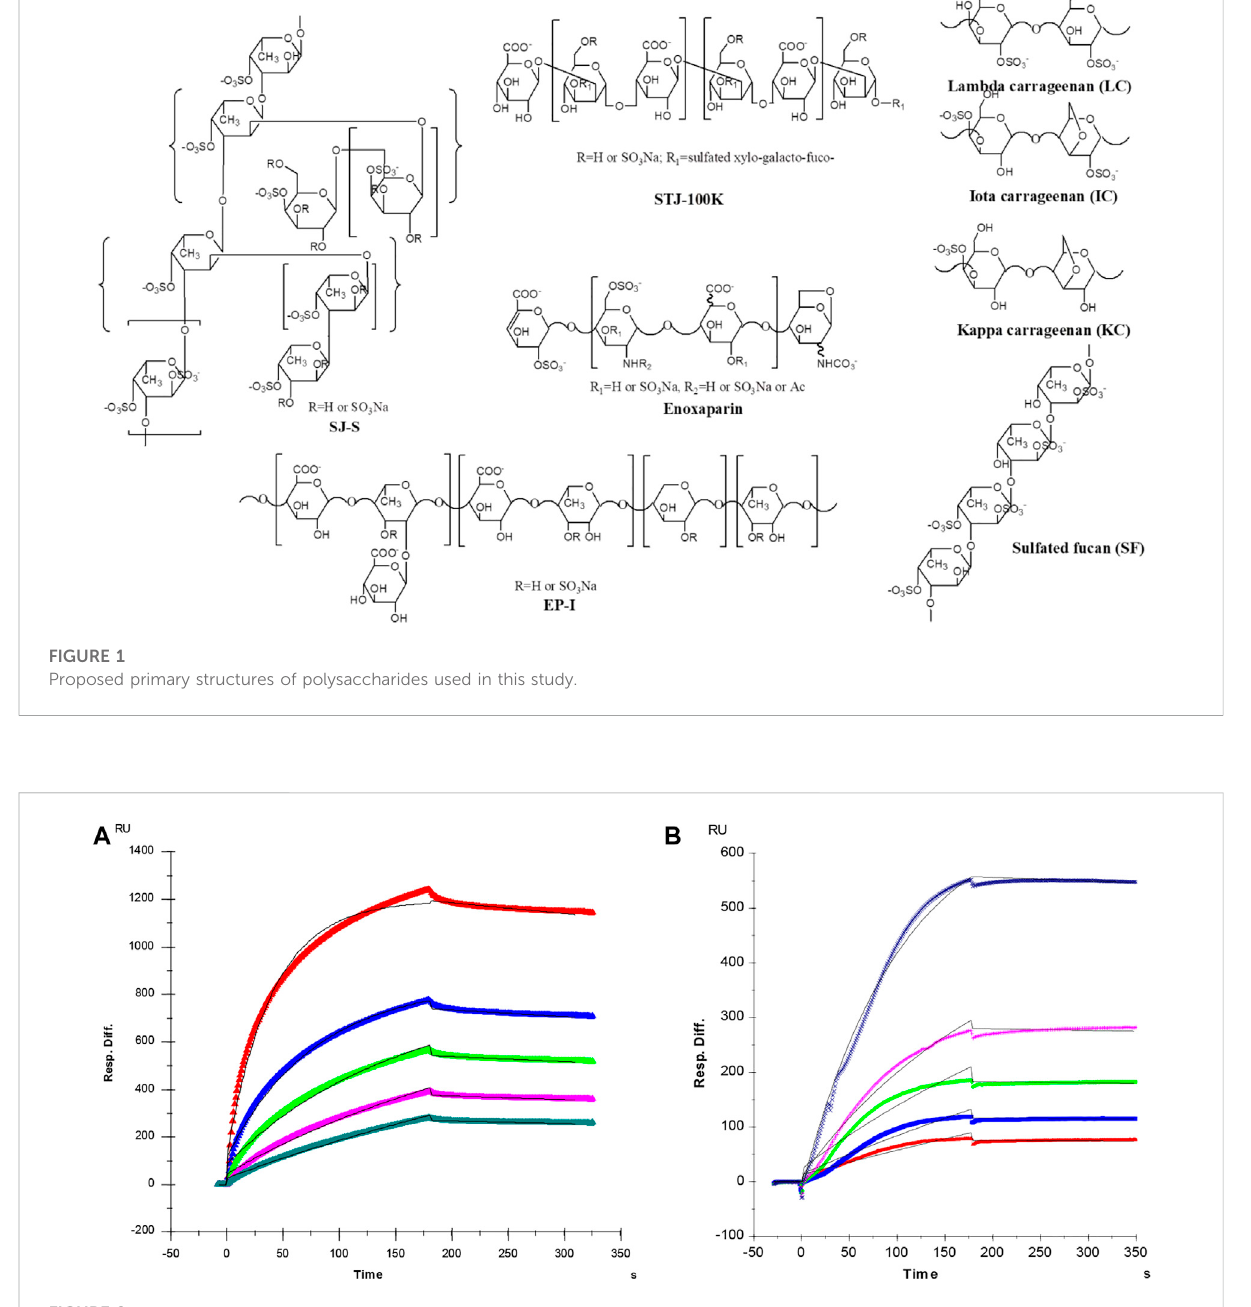
FIGURE 2 (A) SPR sensorgram of AT-heparin interaction. Concentrations of AT (from top to bottom) were 1,000, 500, 250, 125, and 63 nM, respectively. The AT-heparin-binding kinetics were determined by global fi tting the curves to a 1:1 biomolecular reaction model (black lines) using the BIA evaluation software 4.01. (B) SPR sensorgram of PF4-heparin interaction. Concentrations of PF4 (from top to bottom) were 100, 50, 25, 12.5, and 6.3 nM, respectively. The PF4-heparin binding kinetics were determined by globally fi tting the curves to a 1:1 biomolecular reaction model (black lines) using the BIAevaluation software